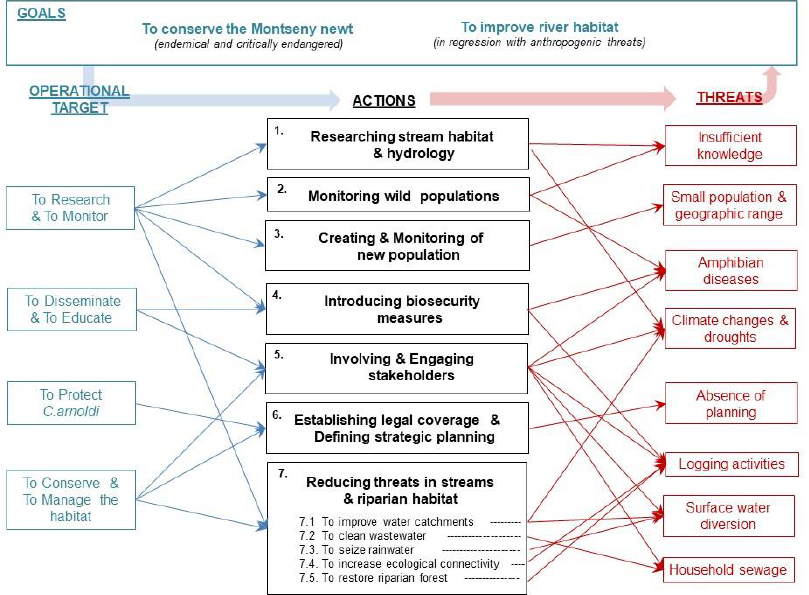
Figure 3. Goals, targets, actions and threats. Two big goals have been established. Of these, four operational targets are specified. To achieve these targets, seven groups of actions have been executed for the different threats to be addressed.